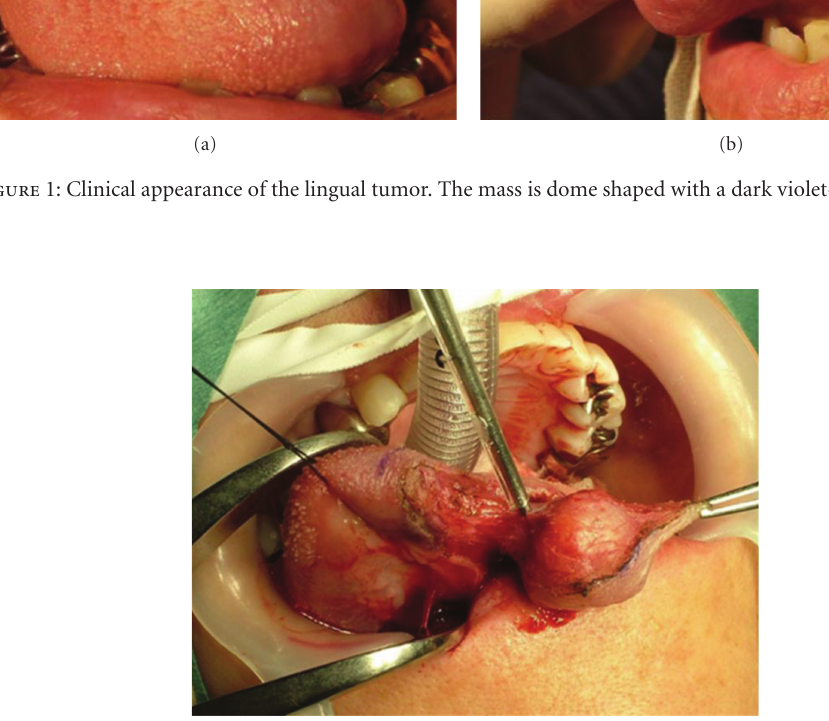
Figure 2: View of surgery. Resection of the tumor was performed using an ultrasonic surgical aspirator, which o ff ers tissue dissection with easy intraoperative hemostasis.